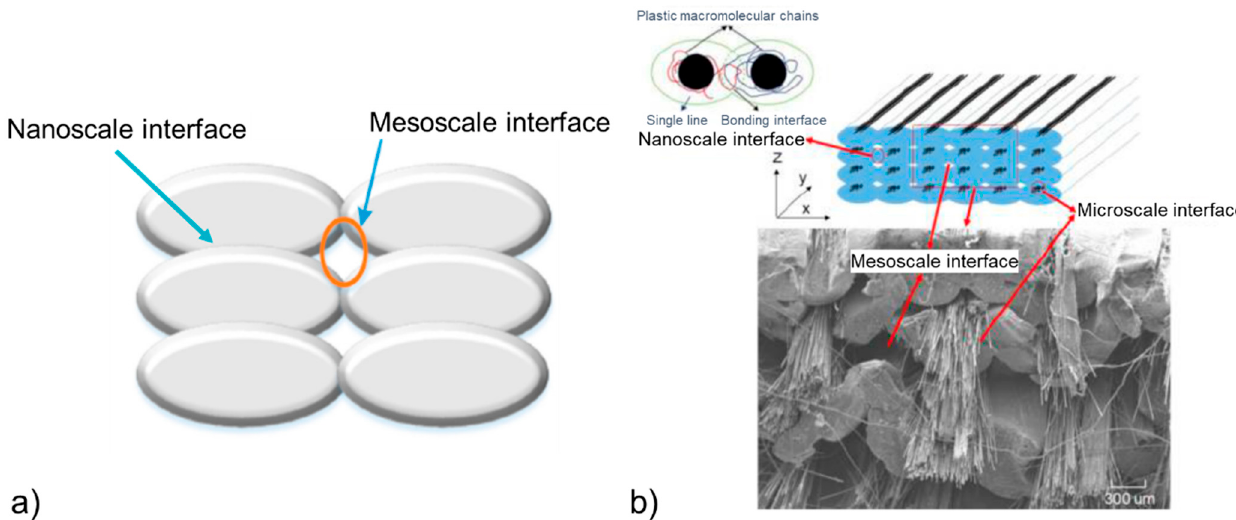
Figure 1. Multiscale interfaces in 3D printed ( a ) neat TPs [5] and ( b ) CFRTPCs [10] (copyright (2017), with permission from Emerald Publishing Limited). Nanoscale and mesoscale interfaces are generated between two and four printing lines, respectively, and microscale interfaces are generated between the TP matrix and the fiber bundle.